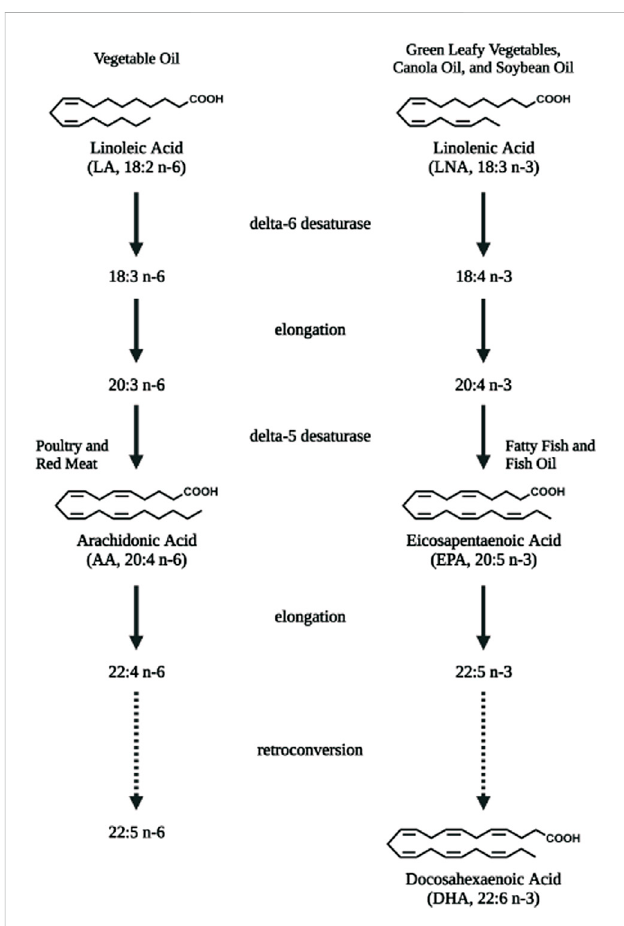
Polyunsaturated fatty acids that serve as substrates for bioactive lipids. Linoleic acid (LA, 18:2 n -6), the essential fatty acid of the n -6 polyunsaturatedfatty acid (PUFA) family is converted to arachidonic acid (AA, 20:4 n -6) via elongation and desaturation. Linolenic acid (LNA, 18:3 n -3), the semi-essential fatty acid of the n -3 PUFA family is converted to eicosapentaenoic acid (EPA, 20:5 n -3) and longer docosahexaenoic acid (DHA, 22:6 n -3) PUFAs via elongation, desaturation aswellasretro-conversionprocesses.Dietarerichsources for these PUFAs. Figure created with